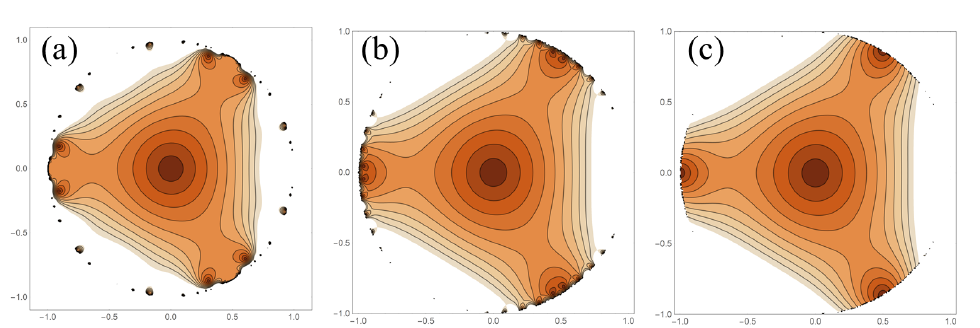
Figure 4. The example of lacunary functions generated from the powers of n . In all cases s = 3 and N = 20. Panel ( a ) shows h ( n ) = ( n − 1 ) 2 . Panel ( b ) shows the case for h ( n ) = ( n − 1 ) 4 . Panel ( c ) shows the case for h ( n ) = ( n − 1 ) 8 . Notice the qualitative similarity among these but the qualitative distinctiveness compared with the lacunary functions generated from the Fibonacci sequence. This is because the power sequence “accelerates” faster than the Fibonacci sequence does, even though the rate of increase ultimately favors the Fibonacci sequence.